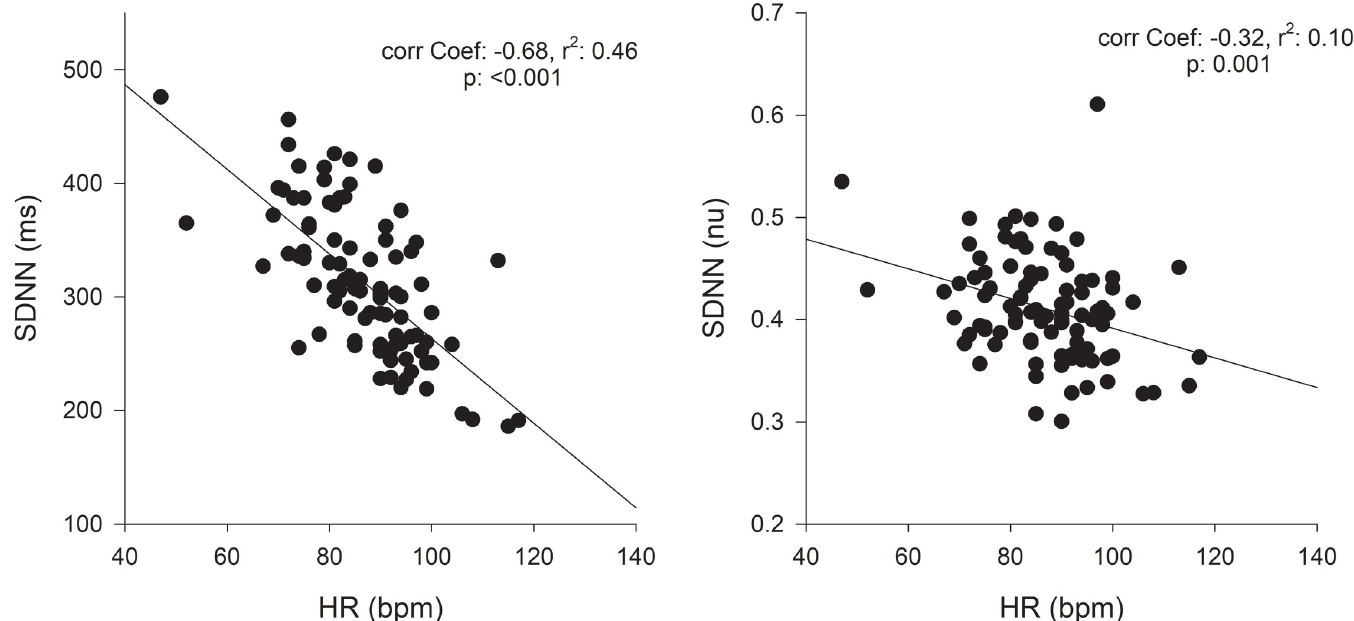
Fig 6. The relationship between mean HR (HR mean ) and heart rate variability (HRV). SDNN: standard deviation of all normal RR intervals. One data point is displayed for each dog Holter (n = 95). The data without and with HR correction (SDNN/mean RR) are displayed in A, respectively. Note that HR only accounted for than 46% (r 2 = 0.46) of the variability before correction for HR. nu, normalized units following HR